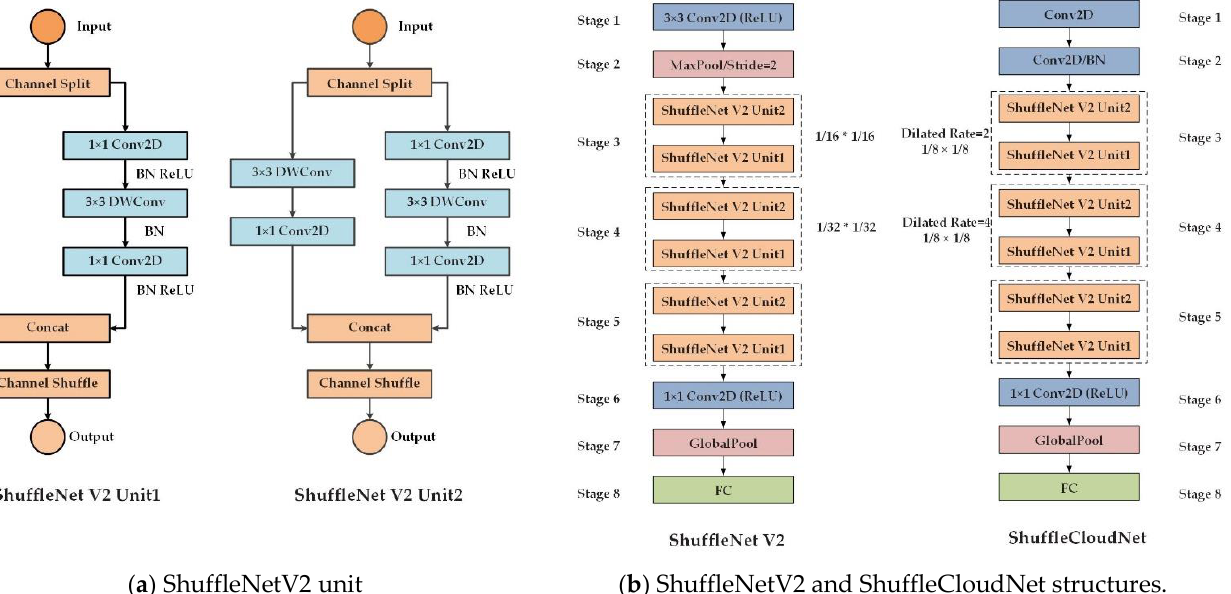
Figure 4. Diagram of the fusion evaluation rules for the composite neural network.